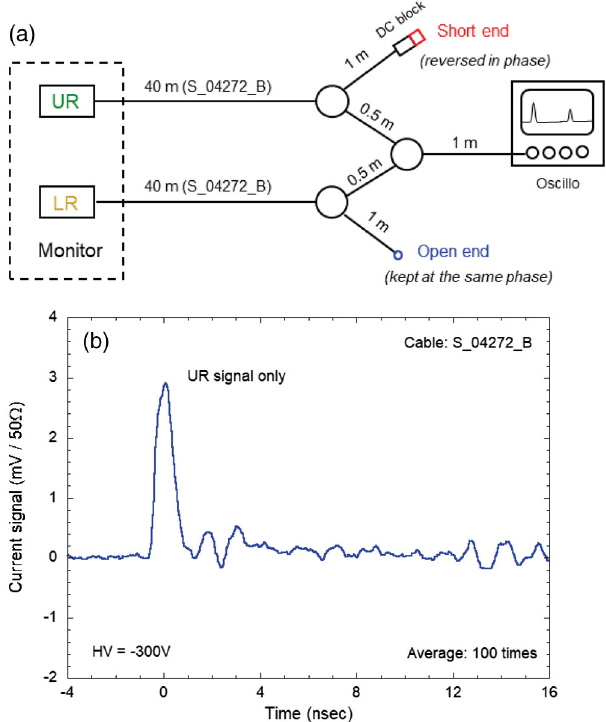
FIG. 20. (a) Configuration of the rf circuit to generate the position sensitive signal. Dividers ( − 6 dB) are shown as open circles. (b) Typical pulse waveform of the current signal. The used cable is S_04272_B (HUBER þ SUHNER).